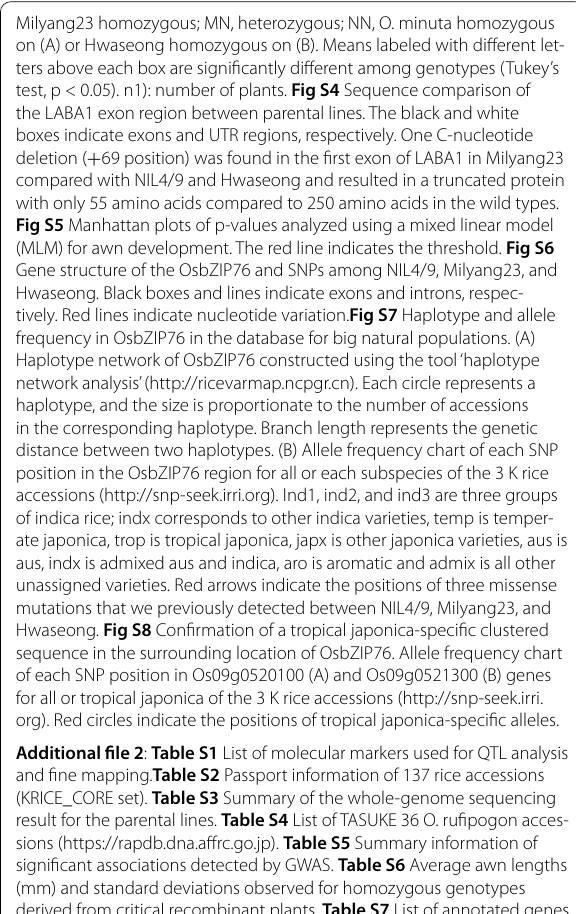
Additional file 2 : Table S1 List of molecular markers used for QTL analysis and fine mapping. Table S2 Passport information of 137 rice accessions (KRICE_CORE set). Table S3 Summary of the whole‑genome sequencing result for the parental lines. Table S4 List of TASUKE 36 O. rufipogon acces‑ sions (https://rapdb.dna.affrc.go.jp). Table S5 Summary information of significant associations detected by GWAS. Table S6 Average awn